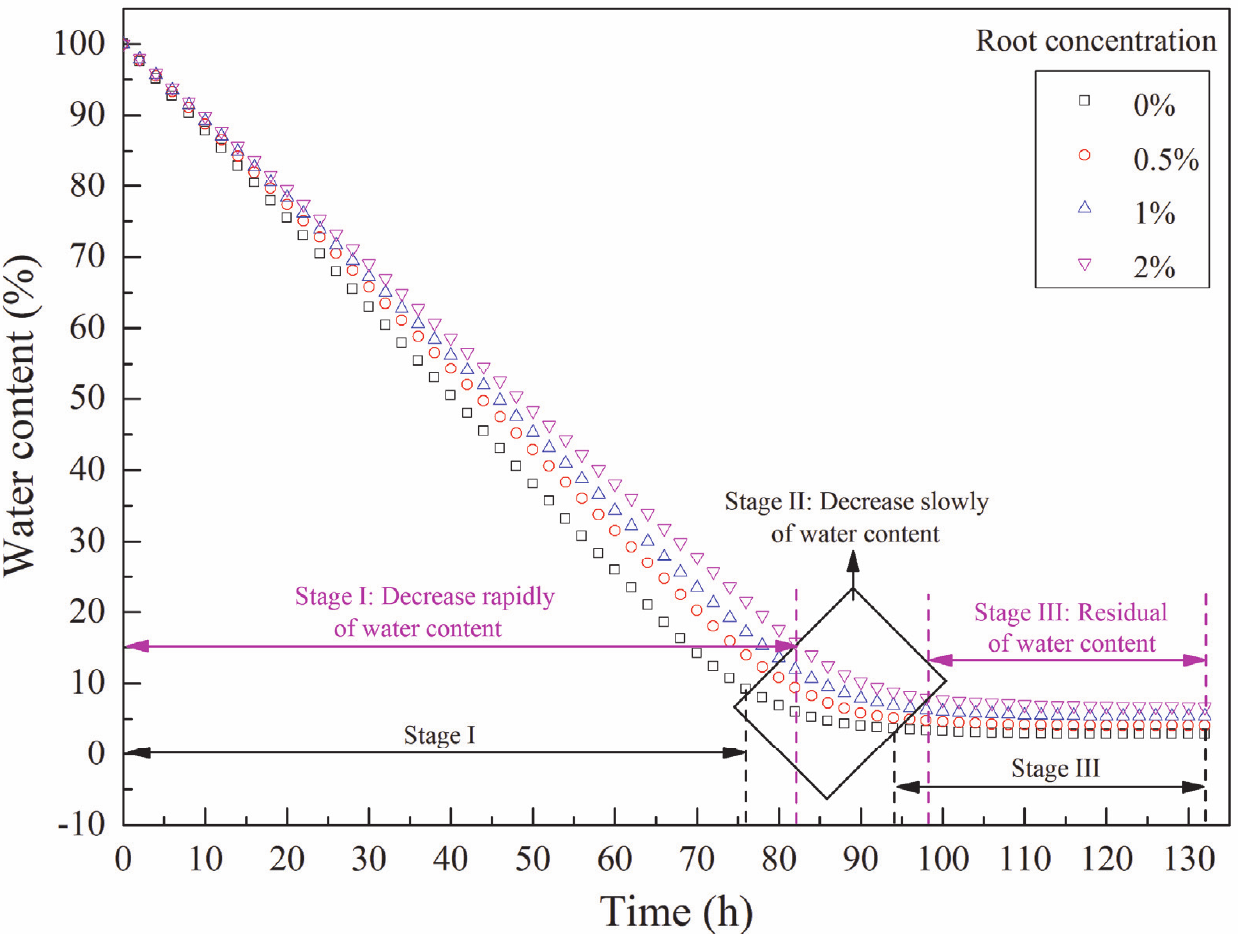
Figure 3. The relationship between water content and time of saline − alkali soil samples.